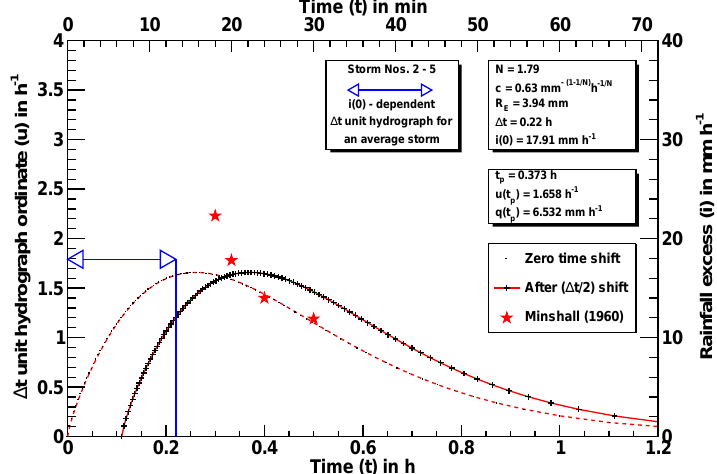
Fig. 6a. Regeneration of the 1t unit hydrograph by the direct Bakhmeteff function method of convolution for an average storm, using the averages of calibrated variable IUH model parameters for four moderate storms, storm nos. 2–5, on the Edwardsville, Illinois, watershed. For comparison, the peak characteristics reported by Minshall (1960) are shown as red stars.